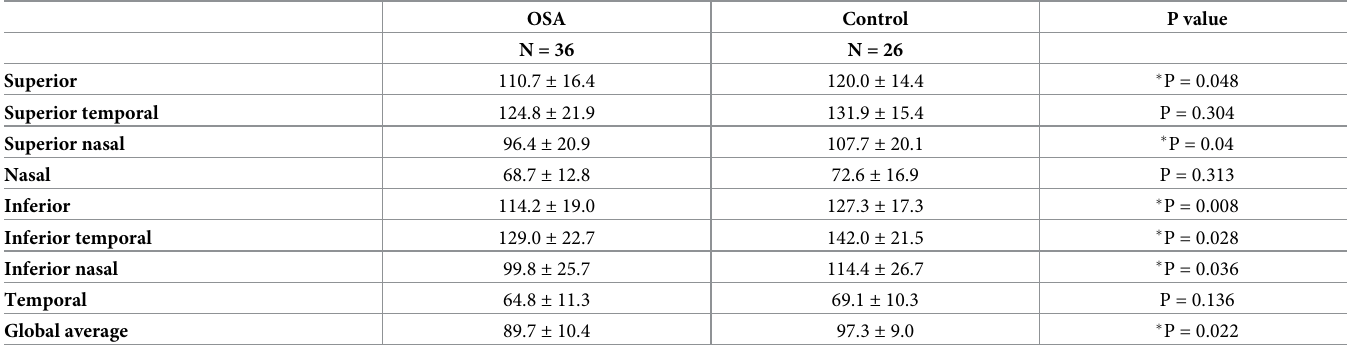
Table 4. Retinal nerve fiber layer thickness ( μ